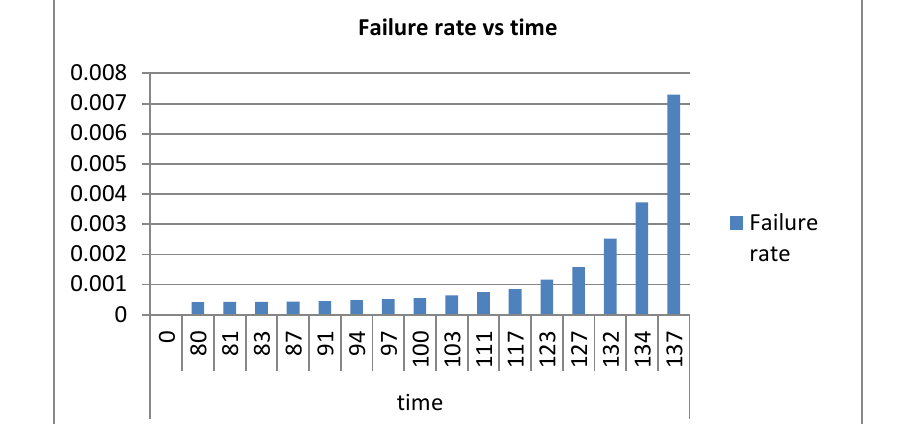
Figure 2. Failure rate vs. time